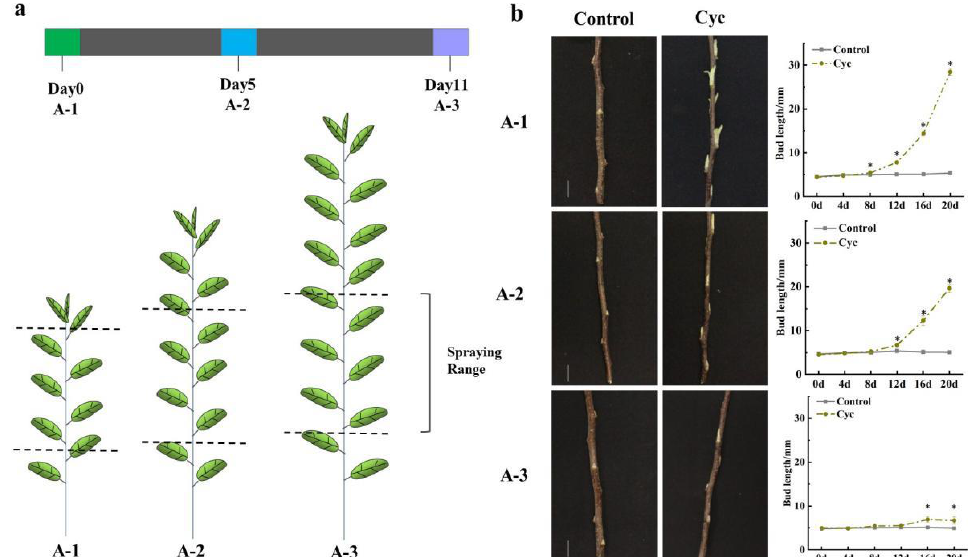
Figure 1. Apple bud phenotype and bud length of axillary buds subjected to cyclanilide application in 1-year apple seedlings. Scale bar = 2.0 cm. ( a ) treatment method; ( b ) bud phenotype and length. Cyc: cyclanilide. Data represent the mean ± SD ( n = 15). Asterisk indicates significant differences based on the Tukey test ( p < 0.05).